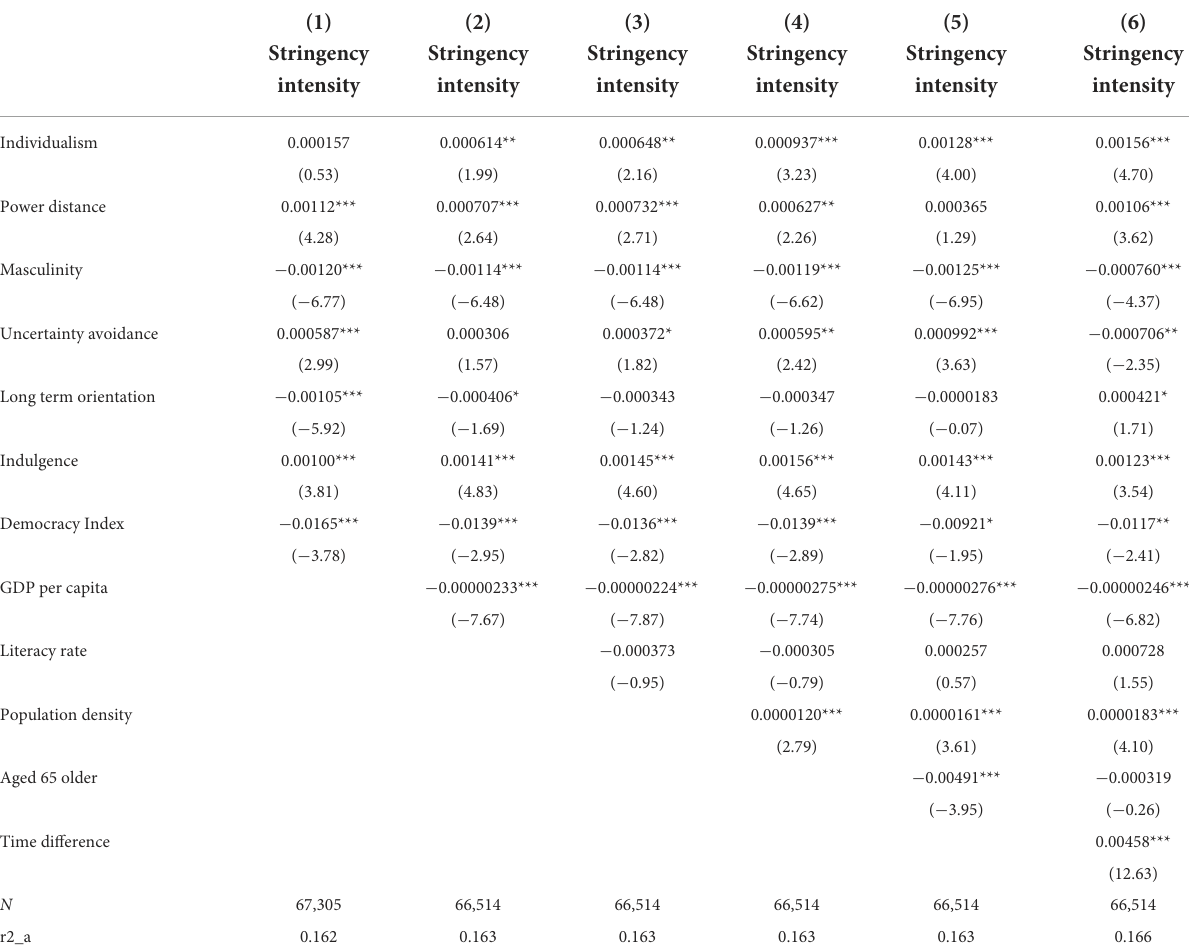
TABLE 4 Impact of 6 culture dimensions on policy